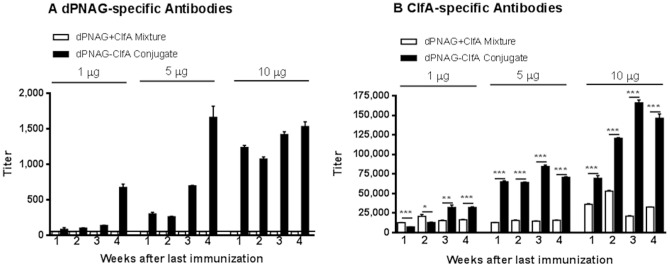
Immunogenicity of dPNAG-ClfA vaccine in mice.Mean titers of IgG antibodies to PNAG and ClfA in sera from mice (n = 10) immunized three times at weekly intervals with 1, 5 or 10 µg of dPNAG−ClfA conjugate vaccine or dPNAG mixed with ClfA (dPNAG+ClfA). Sera were collected weekly for 4 weeks starting 1 week after the last immunization and were tested by ELISA for antibodies to dPNAG and ClfA. A) IgG antibody levels to dPNAG in sera of mice vaccinated with dPNAG−ClfA conjugate vaccine or a mixture of unconjugated dPNAG+ClfA. Horizontal line depicts the limit of detection (titer = 25). For clarity, titers from mice receiving the mixture dPNAG+ClfA, which were below the limit of detection, were assigned a value of the limit of detection. B) IgG antibody titers to ClfA in sera of mice given the dPNAG−ClfA conjugate vaccine or control dPNAG+ClfA. Bars represent means and error bars indicate standard deviations. P as determined by unpaired t test. * P<0.05, ** P<0.005 and *** P<0.0001. All pre-immune titers were <25.